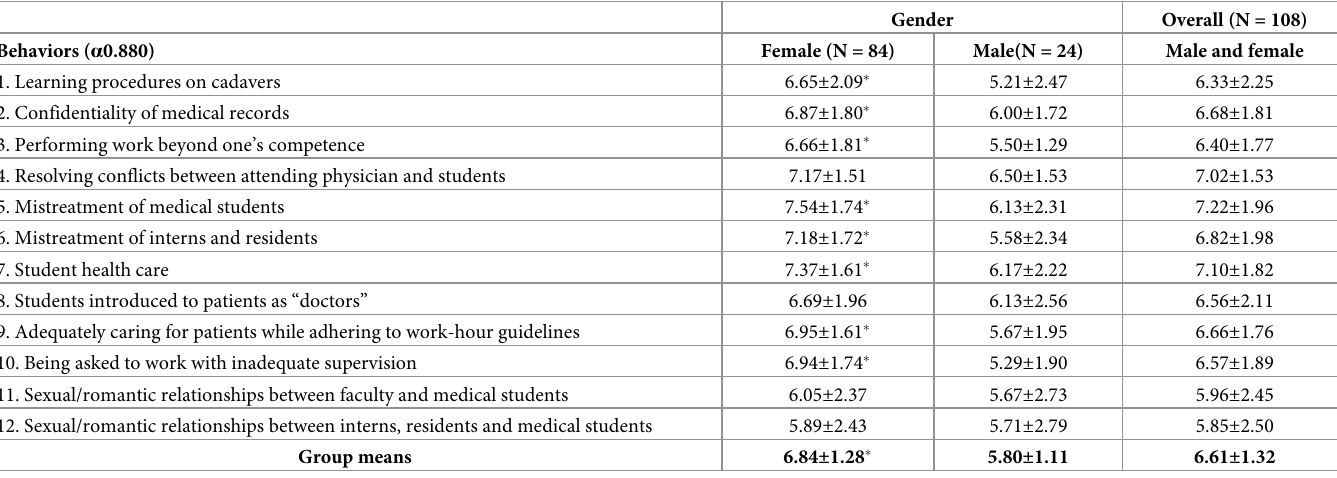
Gender Overall (N = 108)